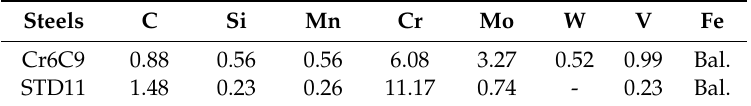
Table 1. Chemical composition of two steels used in the present study in wt.